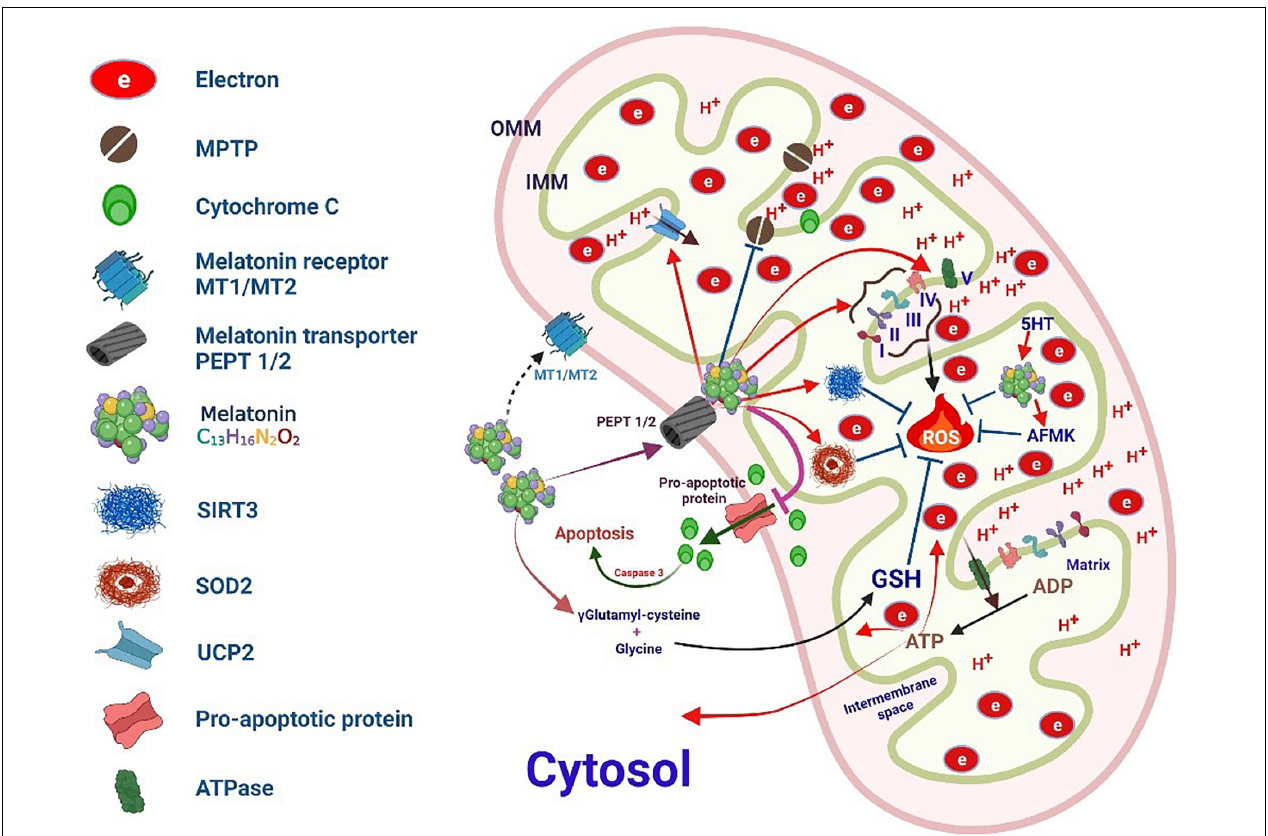
FIGURE 6 | Melatonin targets mitochondrial oxidative